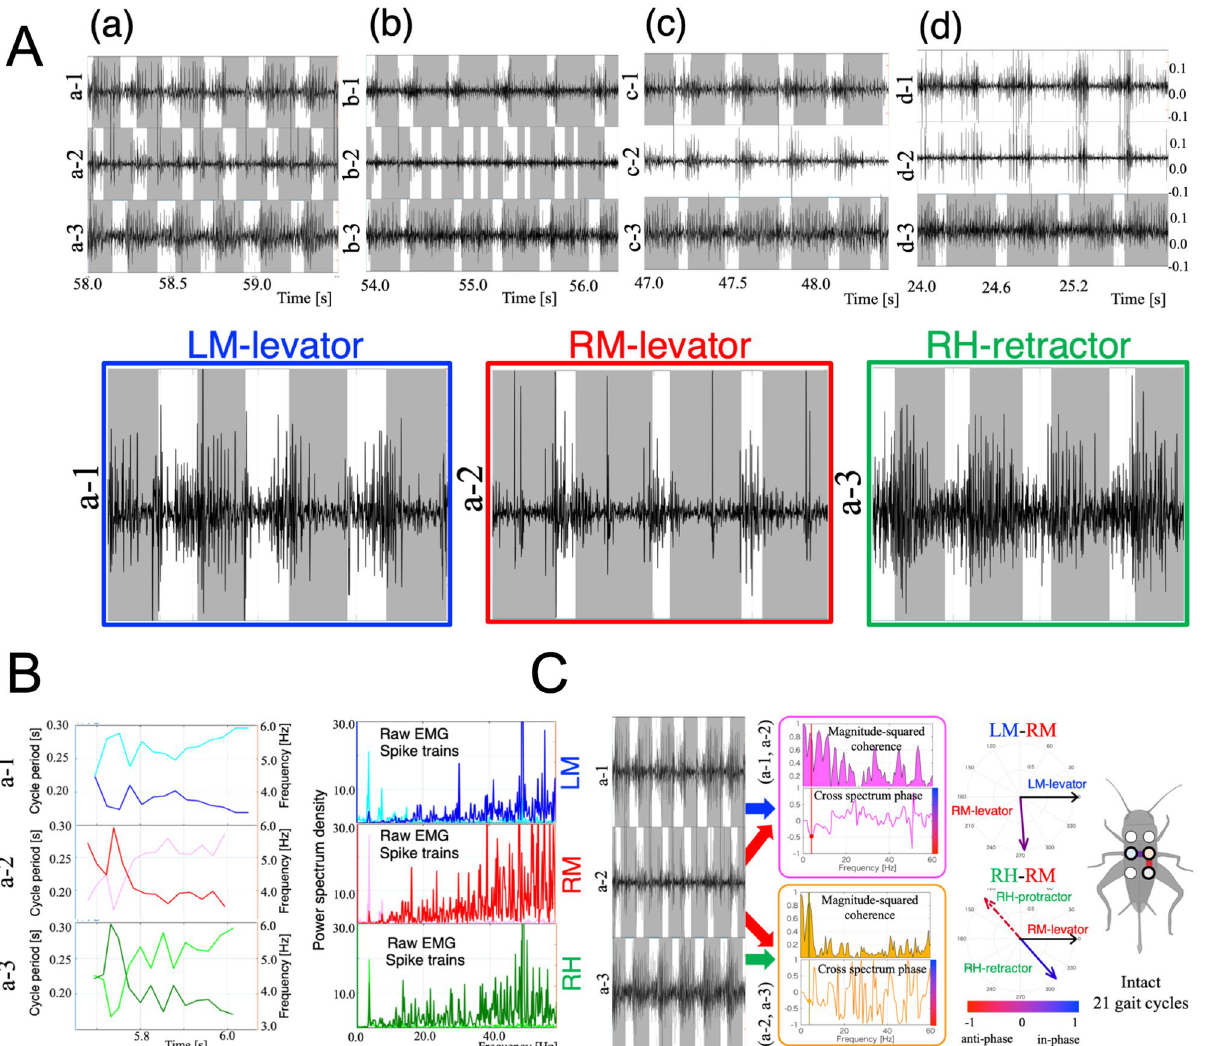
Figure 4. ( A ) Measured EMGs and gait diagrams for four conditions of leg amputation (a) to (d) on Setup 2. In each panel, the upper (e.g. a-1), middle (e.g. a-2), and lower (e.g. a-3) graphs shows the EMG and gait diagram in the left middle (LM, blue), right middle (RM, red), and right hind (RH, green) legs, respectively. The gait diagrams were drawn by visually measuring the duration of the stance phase, which is the period during which legs contact the treadmill. In the gait diagrams, the coloured regions represent the stance phases. The lower graphs illustrate activation of the levators in the LM and RM legs and the retractor in RH leg with highlights during 4 periods. ( B ) Gait cycle period, frequency, and power spectrum density for raw EMGs and their spike trains in A (a). The upper, middle, and lower graphs shows the data from the LM (a-1), RM (a-2), and RH (a-3) legs, respectively. The three graphs on the left show the gait cycle period (light blue, red, and green) and frequency (dark blue, red, and green) that we calculated using the gait diagrams. The three graphs on the right represent the power spectrum density of raw EMGs (dark blue, red, and green) and their spike trains (light blue, red, and green). ( C ) Cross-spectrum analysis for intact walking ( A )(a) over 21 gait cycles. Cross-spectrum analysis extracts a common frequency component and its phase relationship (relative activation timing) between two EMG signals. The upper and lower graphs in the middle region show the results of the analysis for EMG signals of LM-RM (a-1 and a-2, magenta) and RM-RH (a-2 and a-3, yellow), respectively. The upper panels in each graph show magnitude-squared coherence, and the lower panels show the cross-spectrum phase for each frequency. The right circles indicate polar plots of the obtained phase relationship between RM-LM and RM-RH EMGs. The dotted lines in RM-RH polar plots show ’virtual’ protractor muscle activation timing in the RH leg by hypothesising ’quasi’ anti-phase activation against the retractor